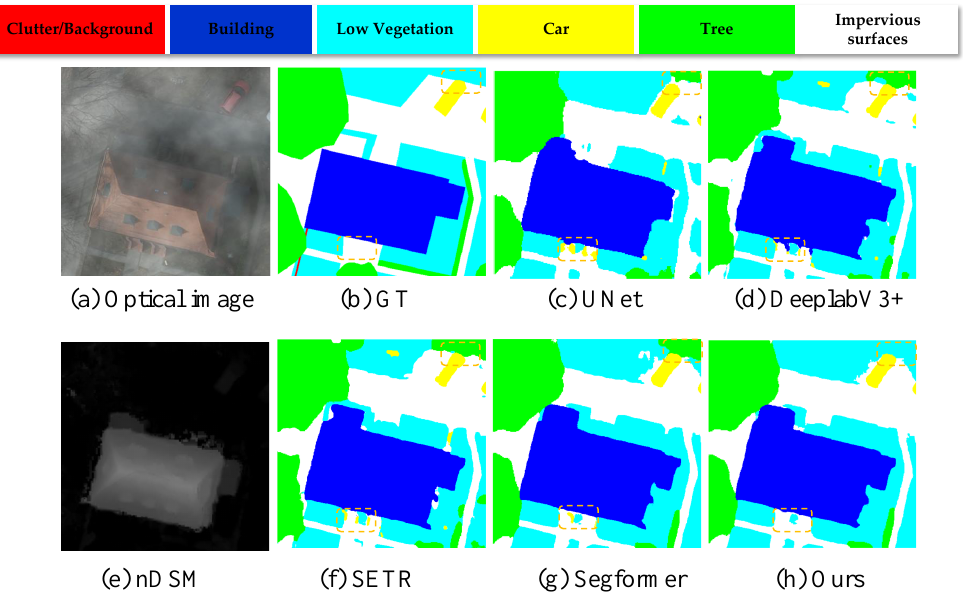
Figure 10. Qualitative comparisons between different methods applied to semantic segmentation of RSIs. The optical image is corrupted by the third severity level of